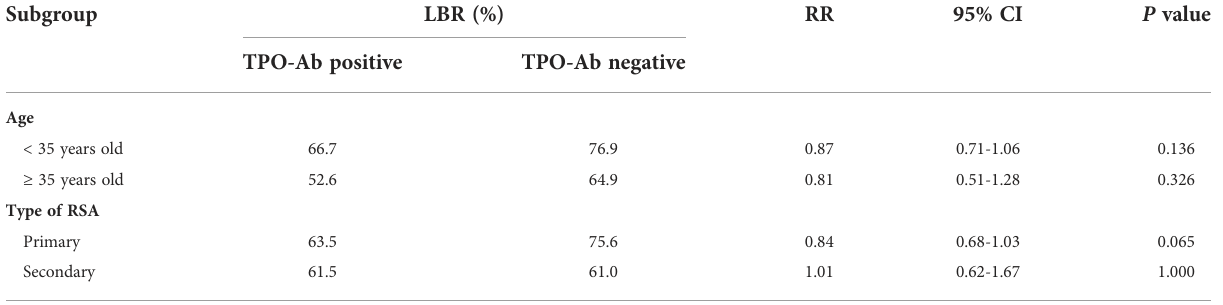
TABLE 4 Subgroup analysis of age and types of RSA on LBR in euthyroid women with URSA.